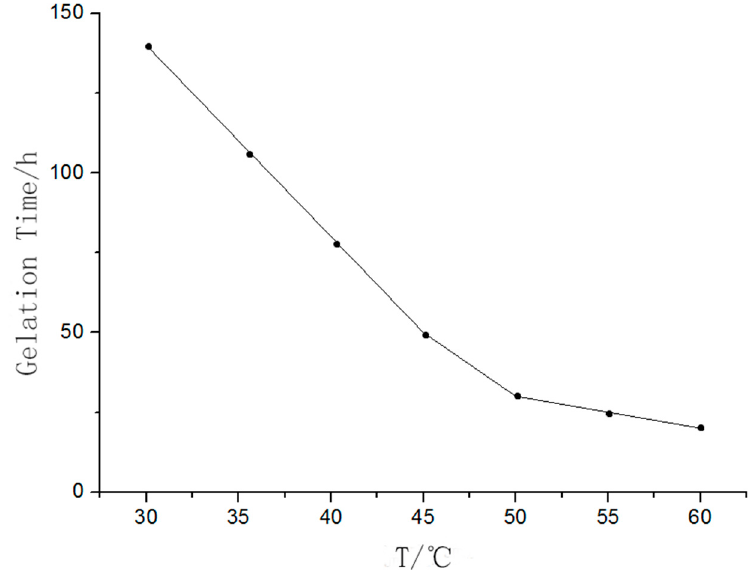
Figure 4. The curve of temperature vs. gelation time.